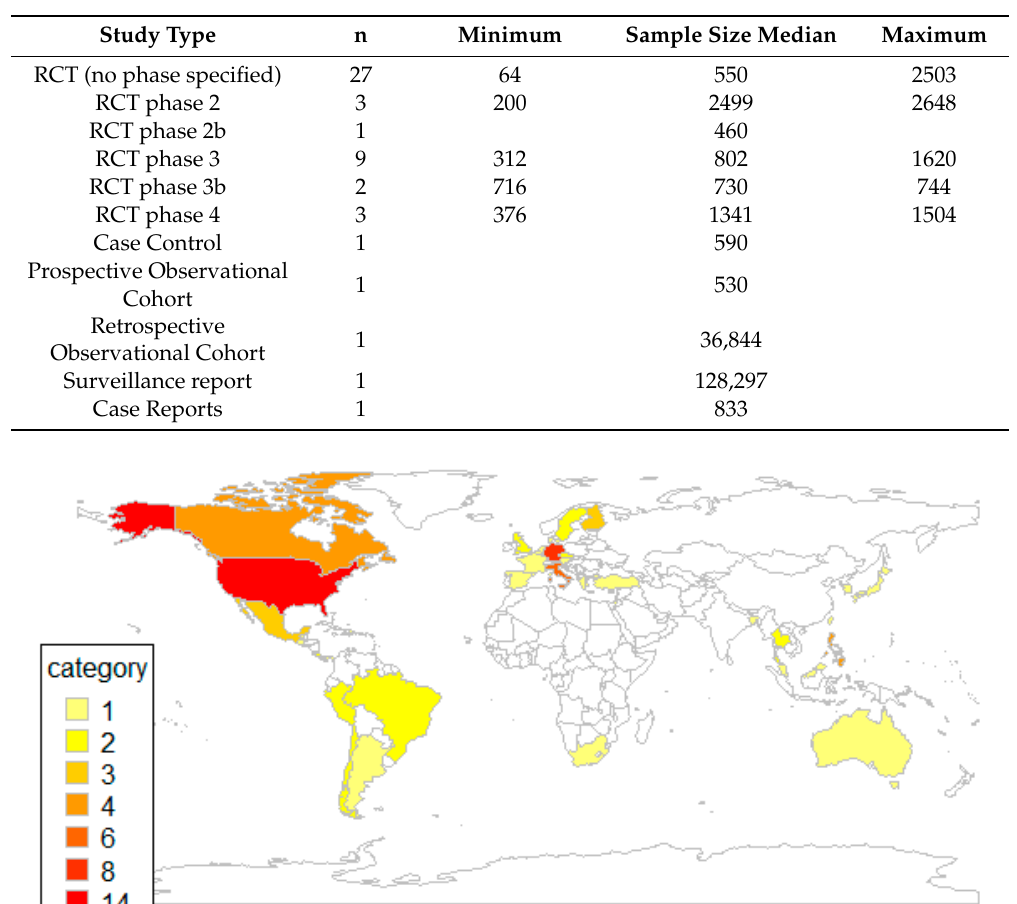
Table 1. Sample sizes by study type.